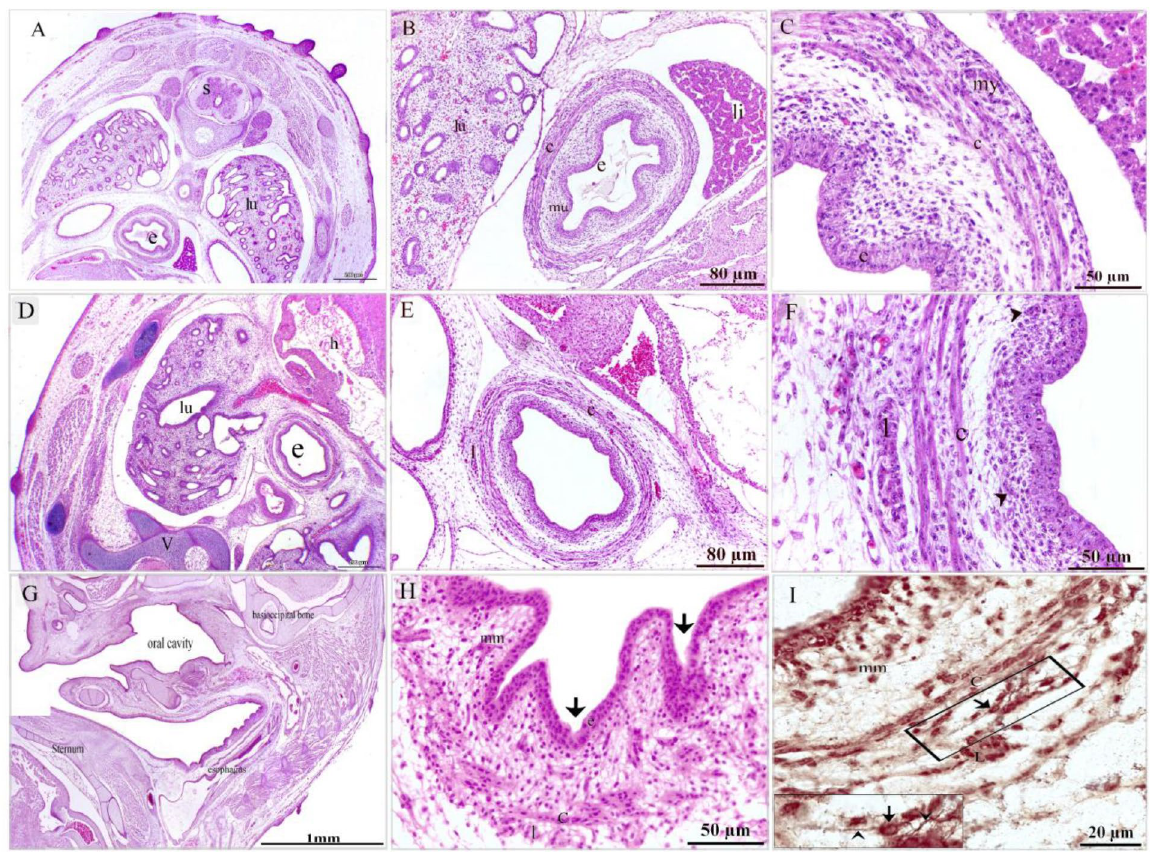
Figure 2. Development of the muscularis mucosae and the longitudinal layer of the muscular sheath. Cross section of day 7 ( A – C ), 8 ( D – F ), 9 ( G – I ) of quail embryo stained with H&E ( A – H ) and Bielschowsky’s Silver ( I ). A: spinal cord (s), lung (lu), esophagus (e). B: esophageal wall consisted of folded mucosa (mu), muscular layer (c), Lung (l), liver (li) C: endodermal cells (en), distinctive circular layer of smooth muscle cells (c), aggregation of myoblasts (my) of the prospective longitudinal muscular layer. ( D ) Esophagus (e), heart (h), lung (lu), vertebrae (v). ( E , F ) The esophagus developed distinct inner circular (c) and outer longitudinal (l) muscular layers. Note aggregated mesenchymal cells (arrowheads) in the mucosal layer. ( G ) The esophagus had folded mucosa. ( H ) the esophagus exhibited distinct muscular bundles, the inner circular (c) and outer longitudinal (l) muscular layers, muscularis mucosae (mm). Mucosal folding (arrow). ( I ) The wall of the esophageal muscular bundles, the inner circular (c) and outer longitudinal (l), muscularis mucosae (mm). Note telocytes Bielschowsky’s silver stain was used to visualize the SMC, which revealed a granular appearance indicating the presence of dense bodies (Fig. 4G–I). The thoracic portion of the esophagus developed highly folded mucosa which exhibited numerous sac-like glandular units, inactive glands (Fig. 5A,B) the epithelial lining had stratified squamous epithelium non-keratinized (Fig. 5C). The cervical portion also had stratified squamous epithelium non-keratinized developed active mucous esophageal glands (Fig. 5D–F). Telocytes were recognized in the lamina propria (Fig. 5E) and submucosa (Fig. 5F). The pseudostratified epithelium and the basal lamina appreaed PAS-positive on the 8th day of incubation (Fig. 6A–C). The developing muscular layers were distinguished by the myoblasts (Fig. 6D), some of which contained PAS-positive glycogen granules. PAS-positive myelin sheaths were also detected between myoblasts (Fig. 6D). On the 15th day of incubation, the thoracic portion of the esophagus was lined by pseudostratified epithelium exhibited PAS activity while the gland was inactive PAS-ve (Fig. 6E–G,J). PAS-ve collagen fibers were identified in the submucosa and muscular layer (Fig. 6G,K). Telocytes exhibited high affinity for PAS (Fig. 6G). The esophageal mucous glands in the cervical portion were now active and contained PAS-positive granules (Fig. 6H,I,L,M). On the 13th day of incubation, epithelial invaginations established sac-like glandular units. The epithelium was pseudostratified type (Fig. 7A–C) and had mucous-secreting inclusions that appreaed metachromatic by toluidine blue but the gland was inactive exhibited -ve PAS reaction (Fig. 7A–E). Mitotic figures were detected in the interstitial cells (Fig. 7B), epithelial cells (Fig. 7C), and SMC (Fig. 7F). On the 15 th day of incubation, the esophagus exhibited distinct mucosal foldings, and the epithelium was now stratified squamous non-keratinized. (Fig. 7G,H). The esophageal mucous glands in the cervical portion were now active (Fig. 7G,H). TEM imaging revealed that the pseudostratified epithelium had superficial mucous-secreting cells (Fig. 8A–D) and the myoblasts developed (Fig. 8B). Most epithelial cells contained RER, ribosomes, and mito- chondria (Fig. 8E), and putative dendritic cells had vesicles and lamellar granules (Fig. 8F). The lamina propria